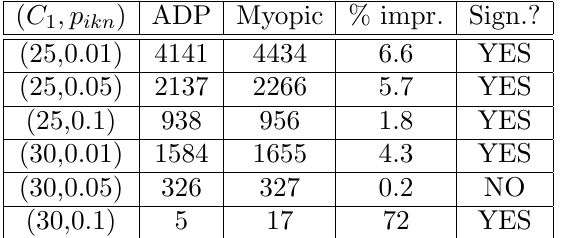
Table 1. Results for the rigid toler- ance case with N = 10.